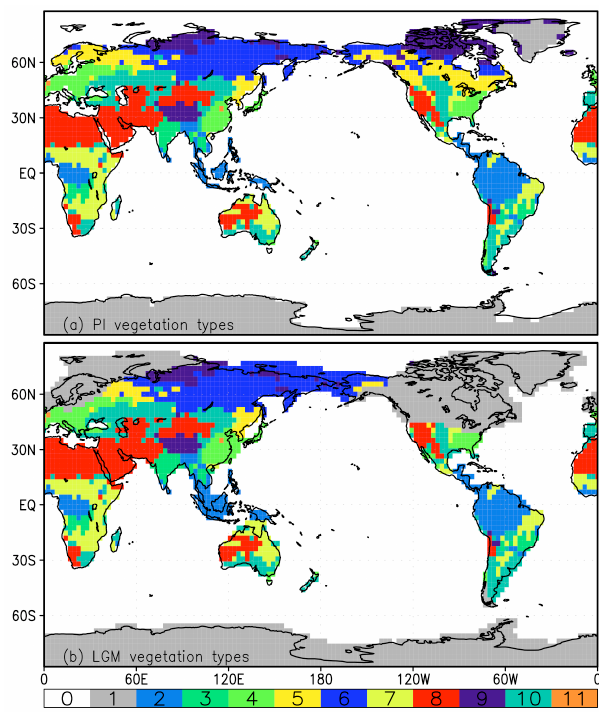
Figure 2. The vegetation types for the land model MATSIRO for (a) PI and (b) LGM. #0 - sea surface, #1 - continental ice, #2 – broadleaf evergreen forest, #3 – broadleaf deciduous forest & woodland, #4 – mixed coniferous & broadleaf deciduous forest & woodland, #5 – coniferous forest & woodland, #6 – high latitude deciduous forest & woodland, #7 – wooded C4 grassland, #8 – shrubs & bare ground, #9 – tundra, #10 – C3 grassland, #11 – cultivation.